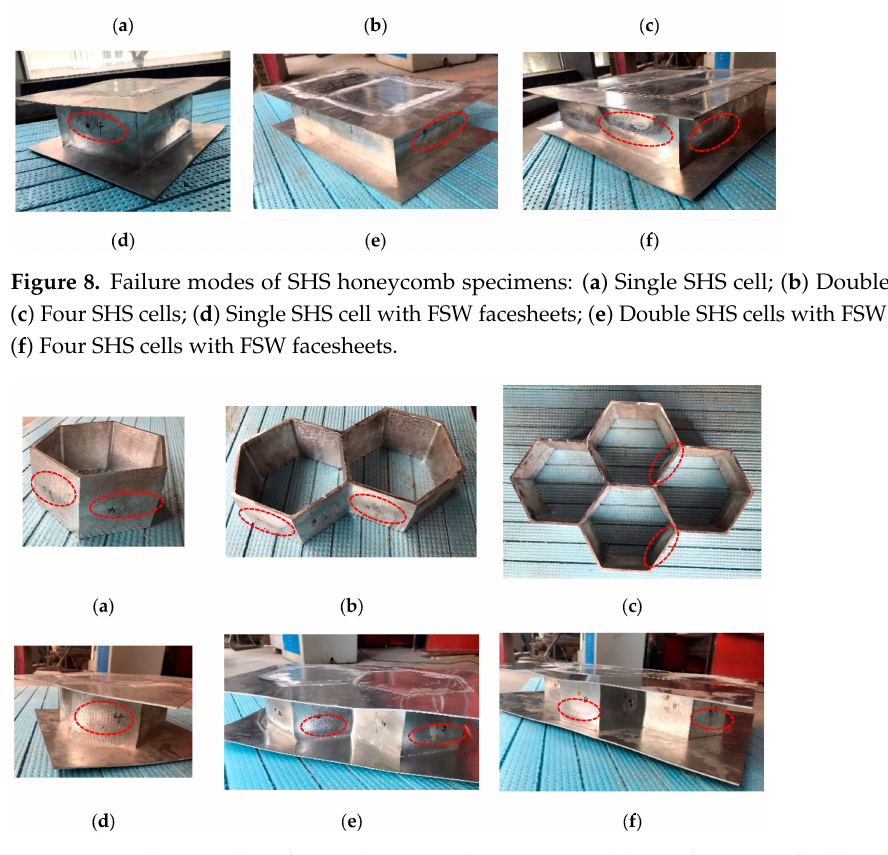
Figure 9. Failure modes of HHS honeycomb specimens: ( a ) Single HHS cell; ( b ) Double HHS cells; ( c ) Four HHS cells; ( d ) Single HHS cell with FSW facesheets; ( e ) Double HHS cells with FSW facesheets; ( f ) Four HHS cells with FSW facesheets.